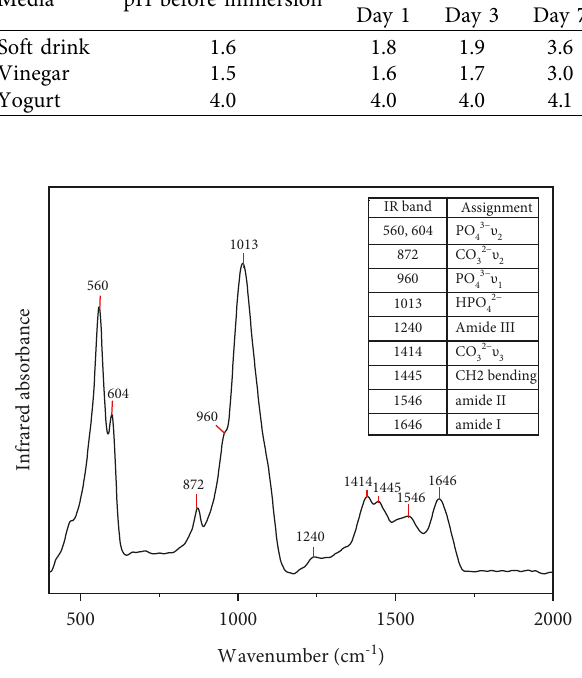
Figure 1: Absorbance spectrum of typical dentin with absorption peaks of the main dentin components and related band